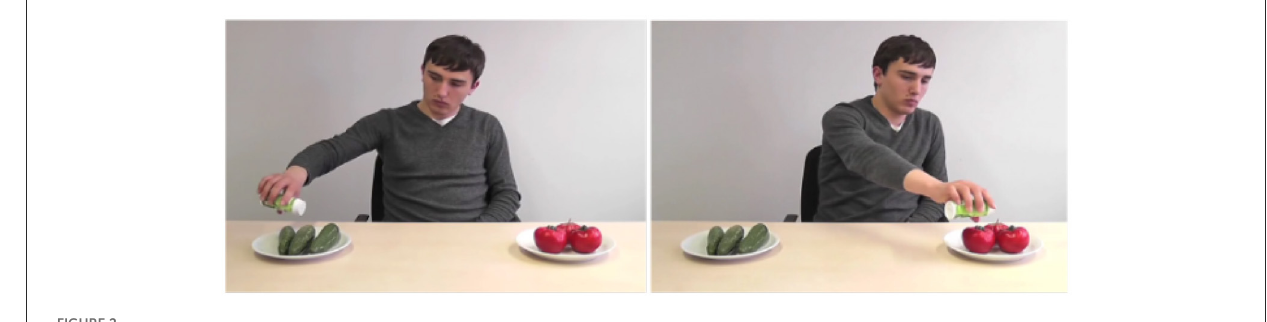
FIGURE2 An example of a display for the memory